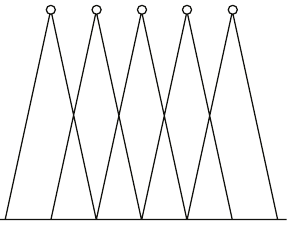
Figure 2: Linear spline basis